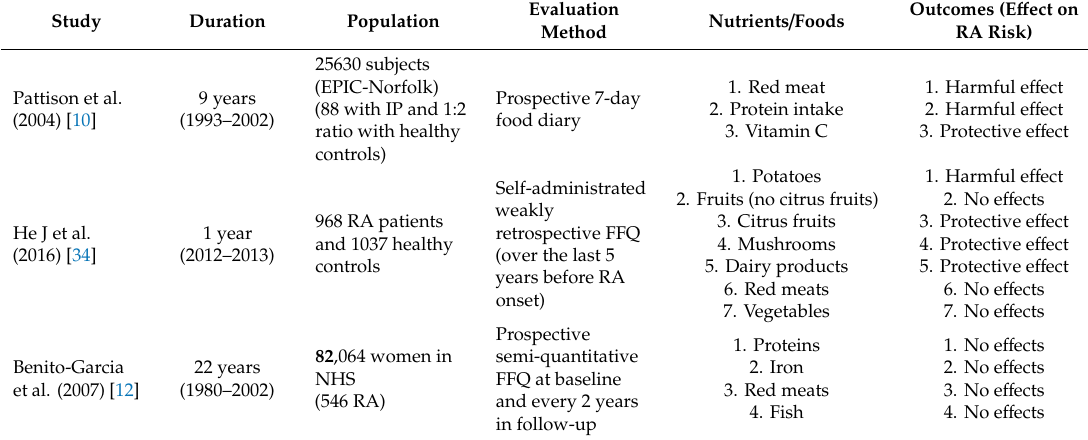
Table 1. Studies on e ff ect of di ff erent nutrients and their food sources on RA